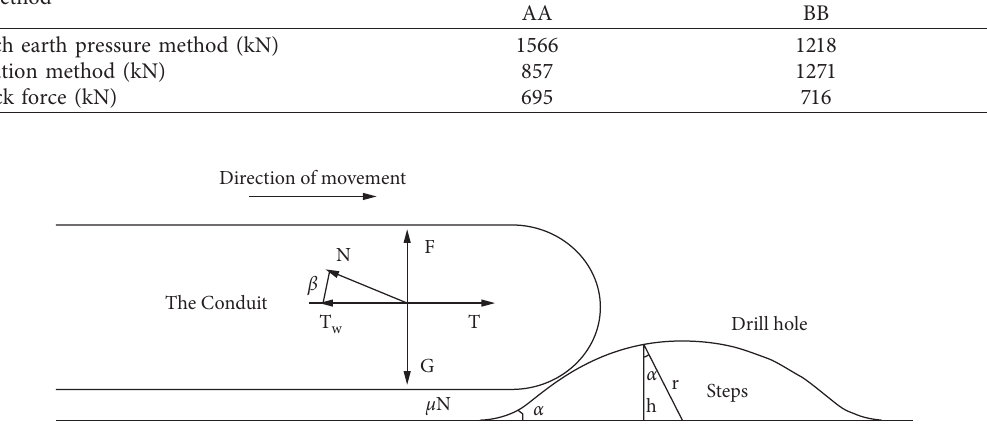
Figure 2: Stress analysis of pipeline crossing steps. Table 3: Stress-strain data of pipeline in plastic